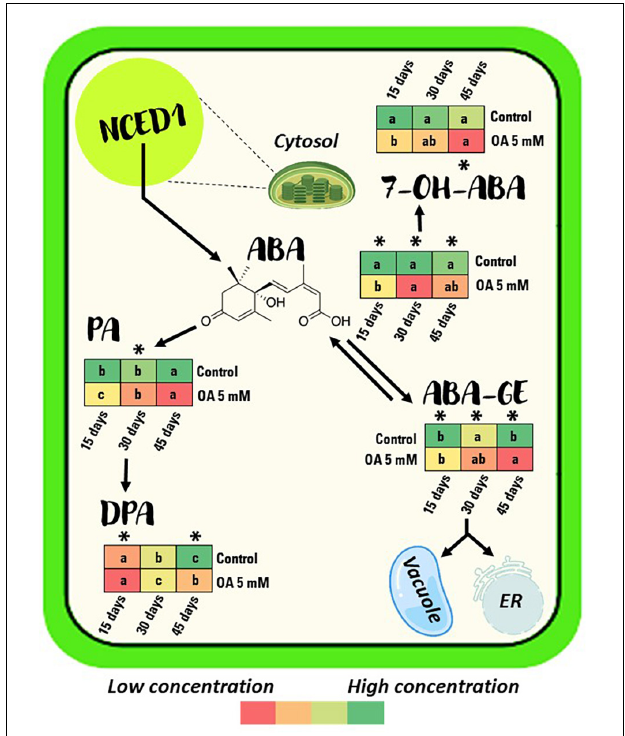
FIGURE 4 | Berry content evolution of ABA and its catabolites content measured in control and 5 mM oxalic acid (OA)-treated ‘Magenta’ table grapes during 15, 30, and 45 days of postharvest storage at 2 ◦ C. Data are the mean ± SE. The colours in the diagram represent the low or high concentration, ranging from red to green, respectively. Significant differences ( p < 0.05 according to Student’s t -test) were expressed as * symbol placed in each column showing differences between treatments for each storage day at 2 ◦ C. Different letters show significant differences ( p < 0.05 according to HSD Duncan’s test) among storage days for each treatment. ABA, abscisic acid; ABA–GE, ABA glucose ester; 7-OH-ABA, 7-hydroxy-ABA; PA, phaseic acid; DPA, dihydrophaseic